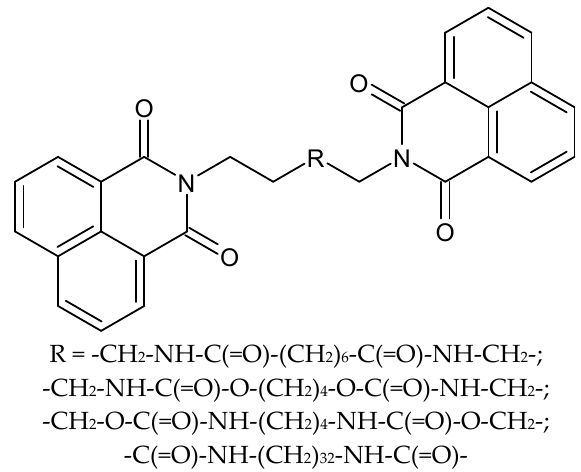
Figure 5. The structures of new analogs of bisnaphthalimidopropyl.